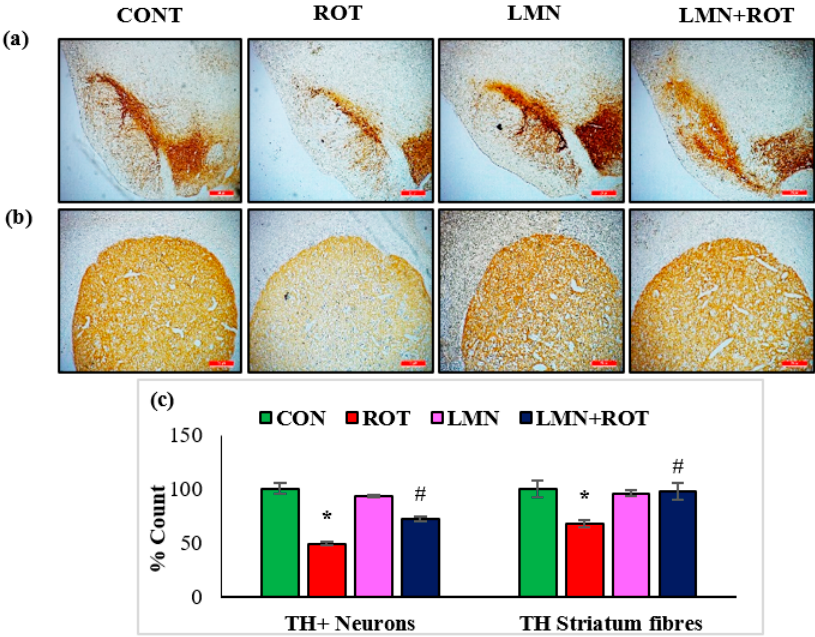
Figure 2. TH-ir neurons and TH-ir fibers in the substantia nigra (SN) and striatum are presented, respectively ( a , b ) (scale bar is 20 µ m). ( c ) Quantification of the TH-ir neurons in SNc and the density of TH-ir fibers is also shown. Each group contains three rats, and the data are represented as percent mean ± SEM. * p < 0.05 CON vs. ROT; # p < 0.05 ROT vs. LMN + ROT (one-way ANOVA followed by DMRT). CON: normal control, ROT: rotenone, LMN: limonene, LMN + ROT: limonene and rotenone treatment.